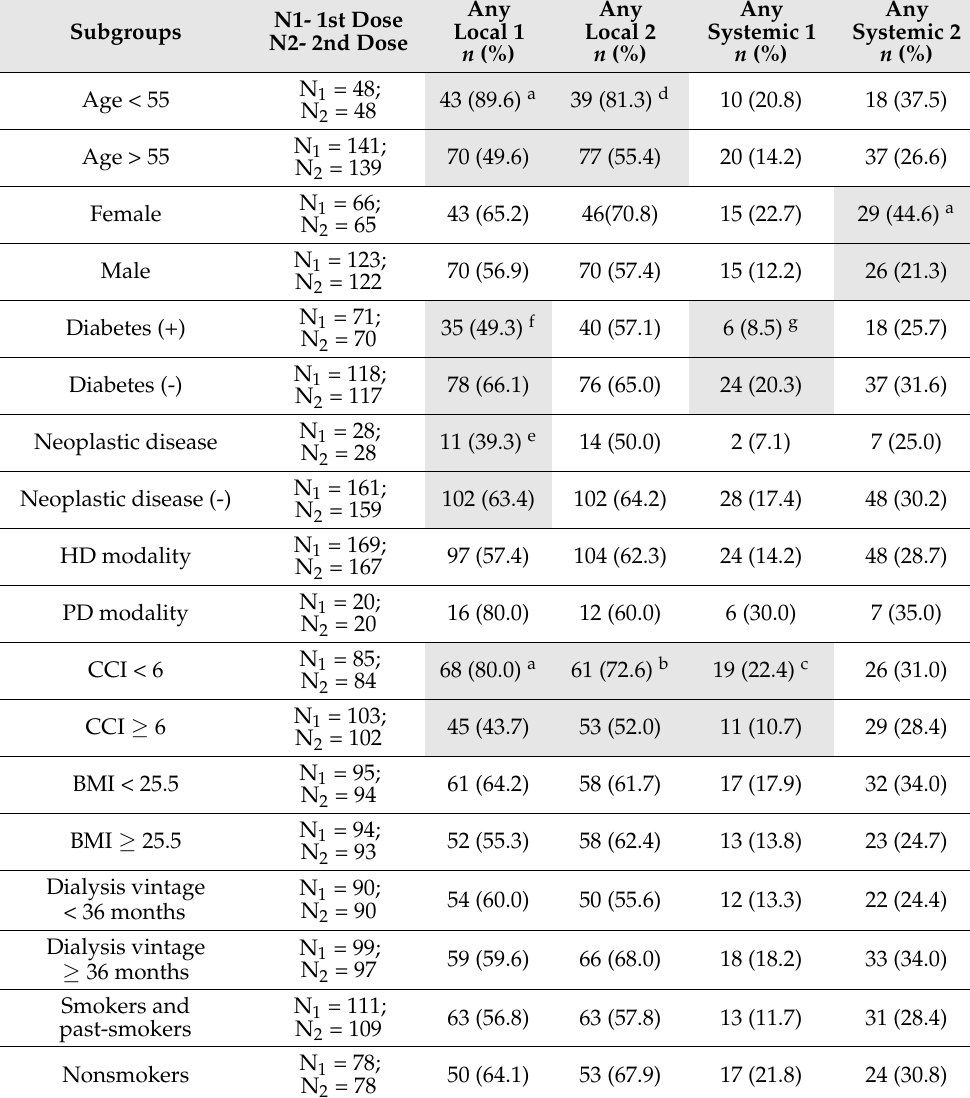
Table 2. Local and systemic solicited adverse events in dialyzed patients in univariable strata analyses.